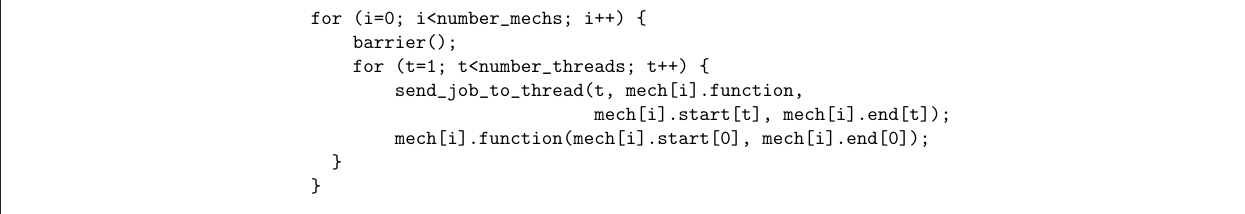
FIGURE 6 | Pseudo-code listing for mechanism type level parallelization. The fi rst thread waits for the other threads to be ready, then assigns them jobs in the form of a mechanism function and parameters that defi ne the fi rst and the last mechanism instance this thread must compute. Finally, the fi rst thread calls the mechanism function